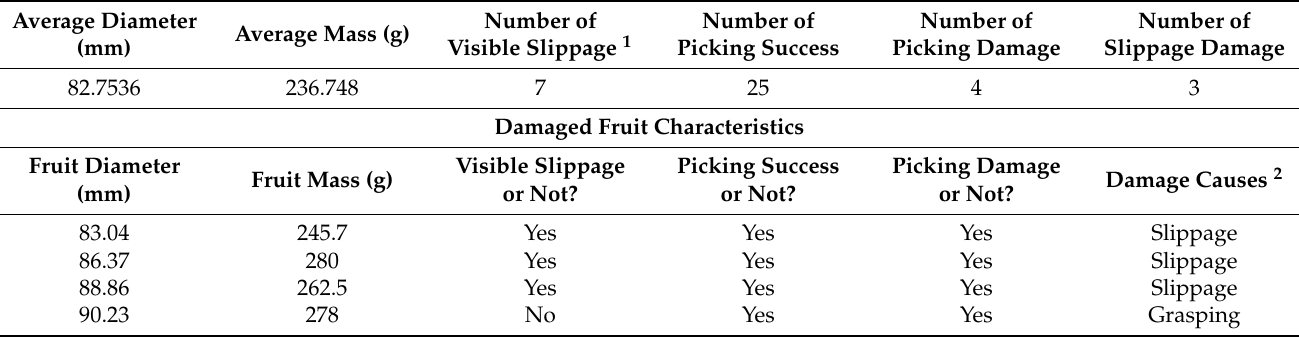
Table 2. The harvesting situation of rigid fingers.